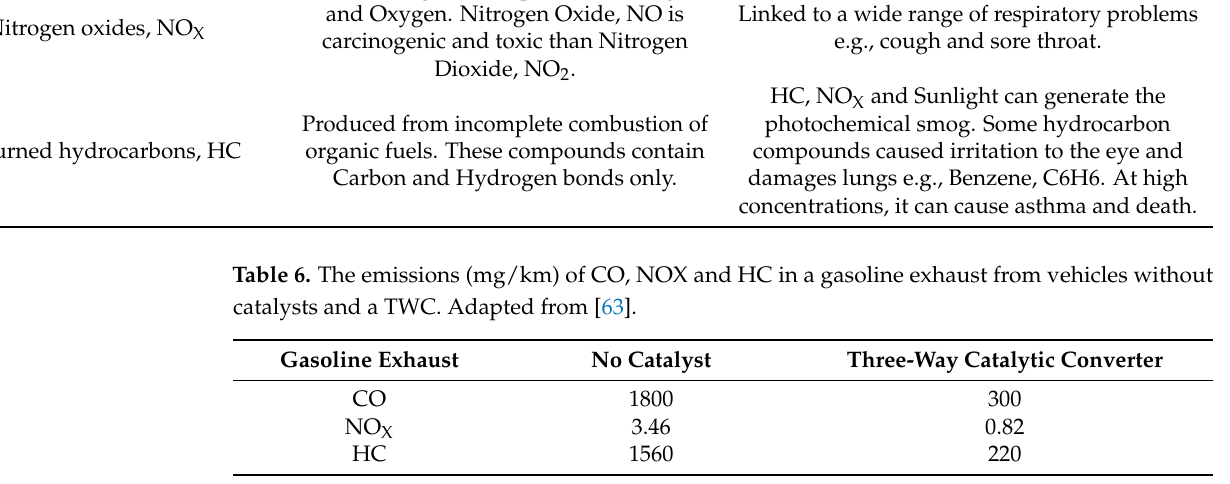
Table 5. Key pollutant gas components, their properties and effect on human health. Adapted from [63]. Pollutant Name and Symbol Properties Effect on Human Health Highly poisonous, odourless, colourless Carbon monoxide, CO and tasteless gas. Flammable.